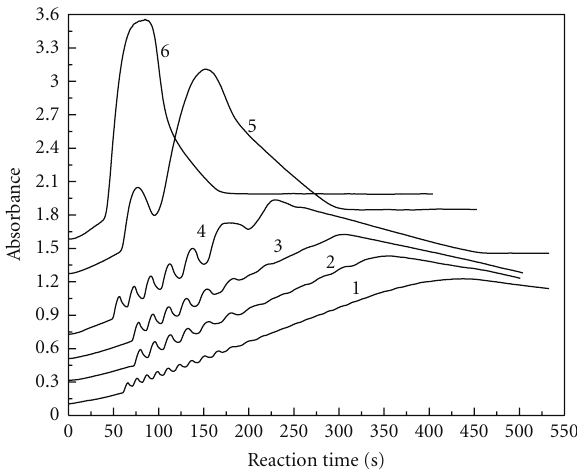
Figure 7: The absorbance versus reaction time at 289nm for the triiodide ion: [MAA] 0 = 6.29 × 10 − 3 mol/L, [KI] 0 = 3.82 × 10 − 3 mol/L, [ClO 2 ] 0 = 5.96 × 10 − 4 mol/L, pH = 2.2 (curve 1), 2.6 (curve 2), 3.0 (curve 3), 3.6 (curve 4), 4.0 (curve 5), 4.6 (curve 6).